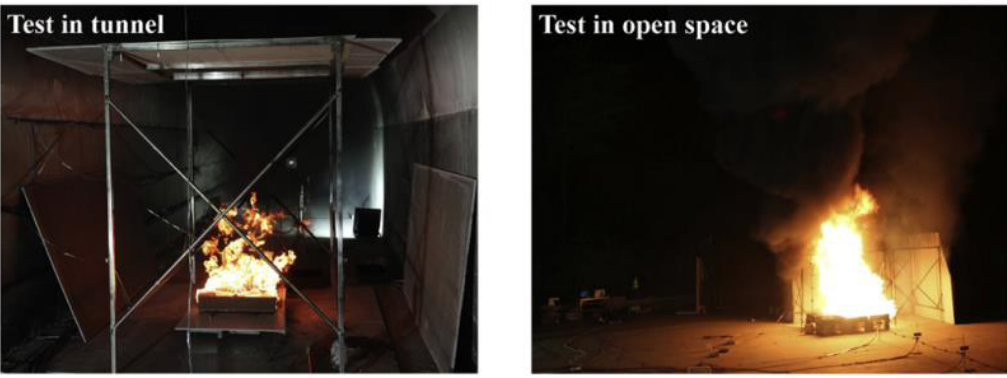
Figure 12. Experimental scenes [60].